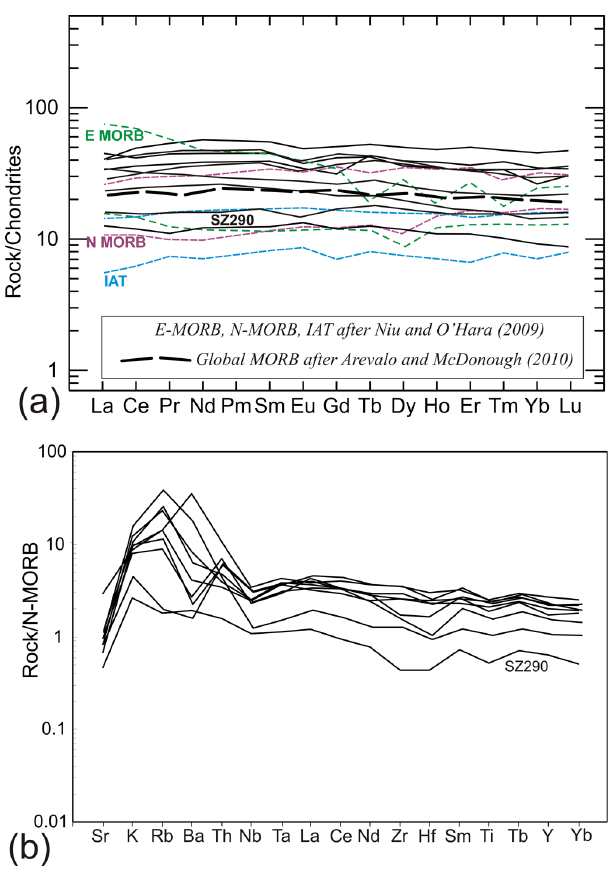
Fig. 6. Chondrite normalised REE patterns (a) and MORB- normalised trace element spider diagrams (b) for the Sabzevar gran- ulites. Normalised values are after Sun and McDonough